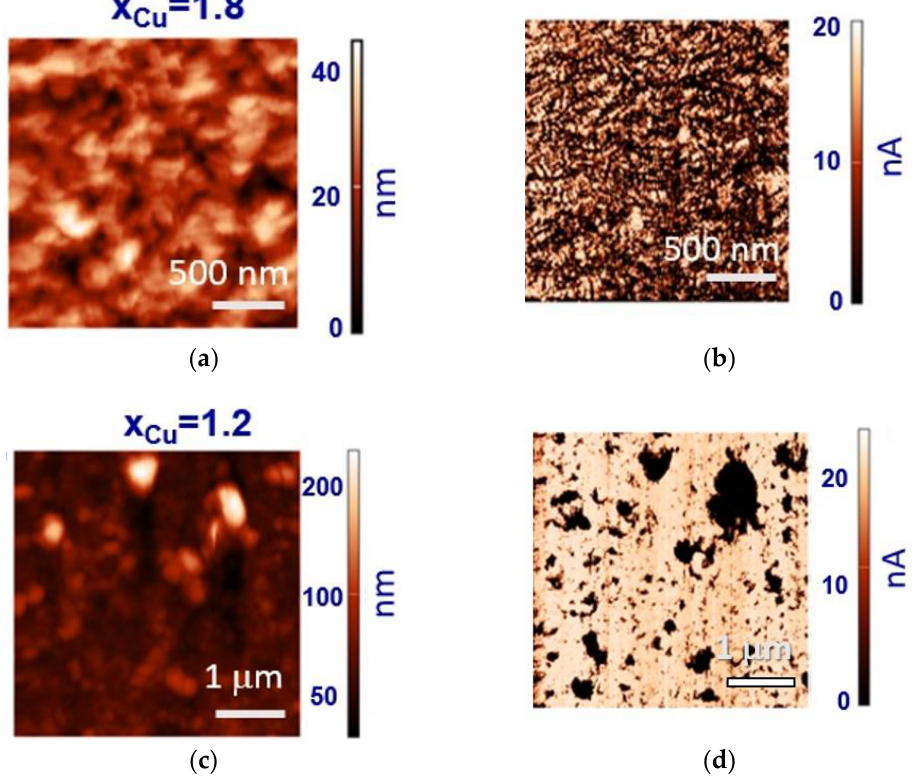
Figure 9. The topology (left) and cAFM maps (right) for samples with x Cu = 2 (Cu 4 ) ( a,b ) and x Cu = 0.7 (Cu 2 ) ( c,d ) after annealing. The applied bias is 1.5 V.